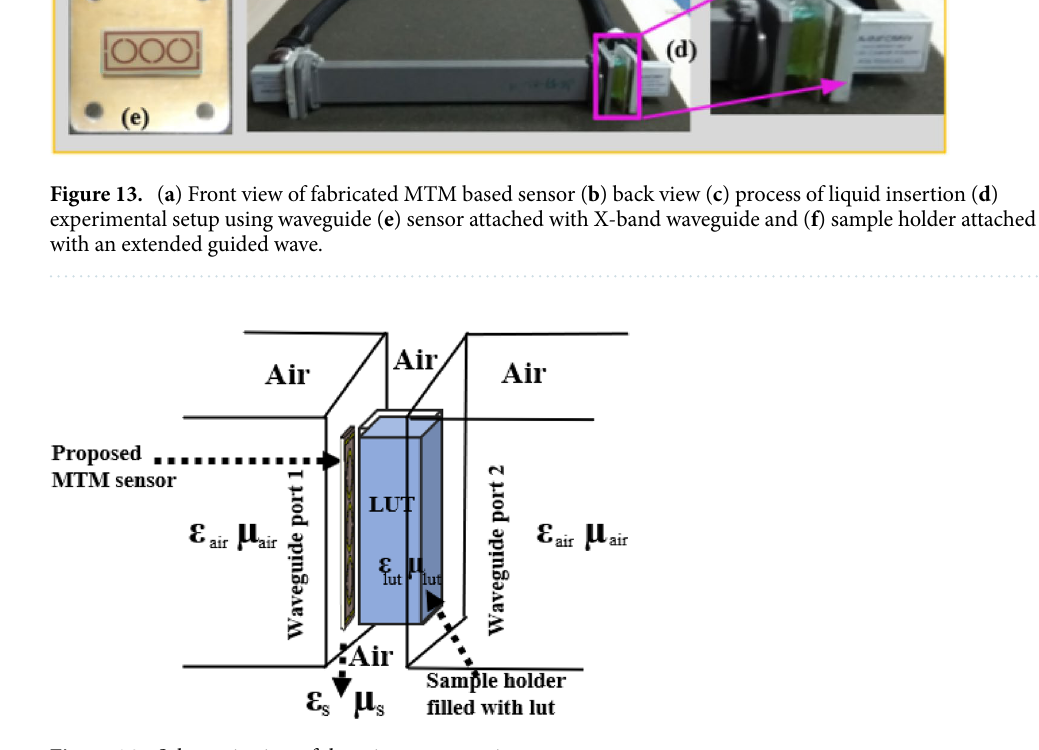
Figure 14. Schematic view of the microwave sensing measurement